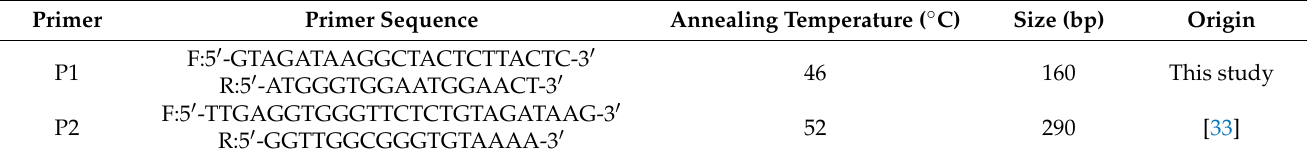
Table 2. Primer pairs for partial Cytb gene amplification of samples from Batrachuperus genus.